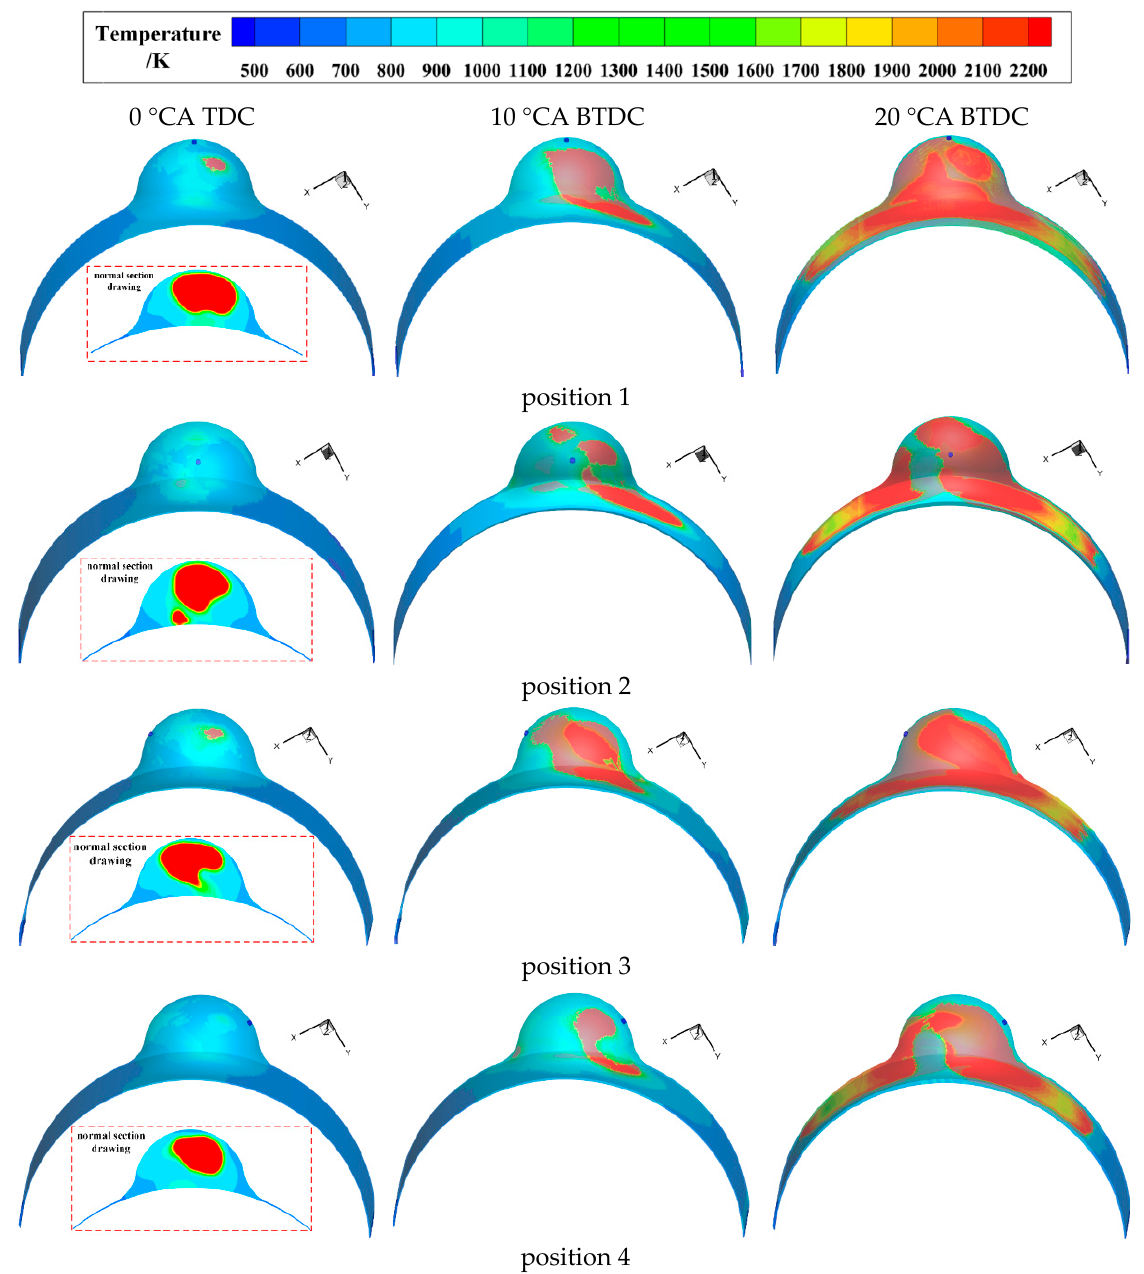
Figure 9. Comparison of temperature cloud atlas in combustion stage at different positions. At 0 °CA TDC, this is the beginning moment of the obvious combustion period. The flame front surface at four positions propagates inside the combustion chamber, thus showing a normal section drawing of the in-cylinder temperature. At positions 1 and 3, the flame has propagated to the outer wall of the combustion chamber’s right; at position 2, the flame propagates to the lower part of the combustion chamber’s rear; at position 4, the flame is all inside the combustion chamber. Combined with the section drawing tem- perature, the high-temperature distribution area under position 4 is the smallest at this moment and its combustion rate is slower. The combustion area is larger under position 2, which is located in the middle and bottom parts of the combustion chamber, respec- tively. At 10 °CA ATDC, this is the middle moment of the obvious combustion period. The difference in the flame front surface under the four positions is large. At position 1, the flame front surface propagates to the right of the combustion chamber’s curved wall and the bottom of the combustion chamber. This indicates that the combustion is mainly in the lower and middle parts of the combustion chamber’s right. At position 2, the flame spreads widely. The flame front surface is distributed on the top and right, the bottom and rear of the combustion chamber. Meanwhile, a part of the flame has begun to spread to the right slit. Although the area shown by the flame front surface on the wall of the combustion chamber is not very large, it can be seen that the inside combustion is very intense. At position 3, the flame front surface has propagated to the curved wall, the bot- tom, and the rear of the combustion chamber. It shows that the flame area is more concen- trated, mainly located in the middle of the combustion chamber and the combustion range is larger. At position 4, the combustion area is mainly concentrated in the lower of the combustion chamber. Furthermore, the flame front surface spread to the curved wall sur- face and the bottom of the combustion chamber. However, the distribution is less, indi- cating that the combustion at position 4 is relatively less intense. Therefore, the combus- tion areas at this moment are all located in the spherical combustion chamber and are the largest at position 2 and the smallest at position 4. At 20 °CA ATDC, this is the end moment of the obvious combustion period. The temperature cloud distribution tends to be the same at four positions. Specifically, the flame is mainly distributed in the spherical combustion chamber and the slit on both sides. At this time, the combustion rate has slowed and the main difference is shown in the com- bustion on both sides of the slit. It was found that the slit burning area at positions 1 and 2 is larger than that at positions 3 and 4. At position 3, the burning area on the left side of the slit is smaller than the right side; at position 4, the burning area on the right side of the slit is smaller than the left side. Since hydrogen is injected from different positions, the hydrogen distribution between the left and right sides is not uniform. On the whole, after hydrogen injection into the cylinder, the basic development course of the flame is as follows. Firstly, XRE ignites in the center of the combustion cham- ber to form a stable flame kernel. Then, the combustion area and combustion speed are different in the cylinder according to the distribution of hydrogen. At different positions, the combustion area is the larger and the combustion speed is the fastest at position 2, followed by that at position 3. Meanwhile, the combustion area is significantly smaller